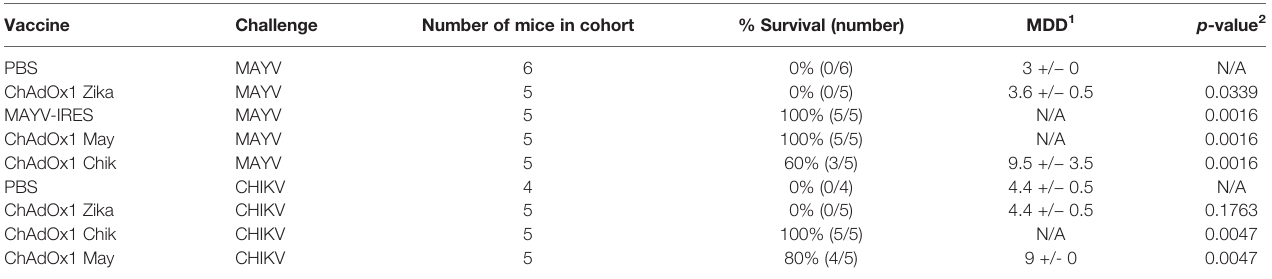
TABLE 1 | Survival of A129 mice challenged with Mayaro virus ( MAYV) or chikungunya virus (CHIKV).